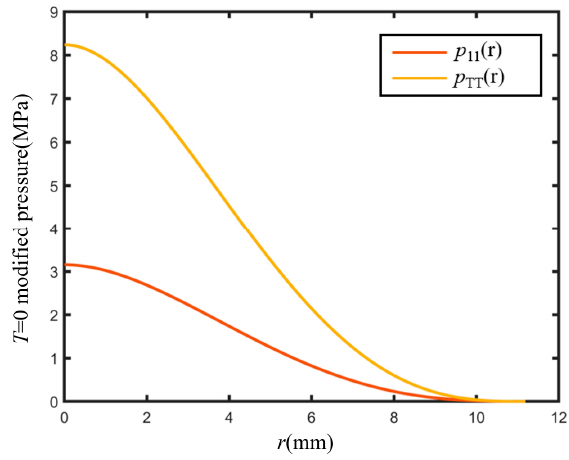
Figure 11. Third discrete pressure correction curve ( T = 0 N, n = 3). When T = 554 N, the normal force in the discrete area before and after preload correction can be obtained, as shown in Table 8, where ω T is 4.813. Table 8. Normal forces of discrete areas of constraint method ( T = 554 N, n = 3). Normal Forces